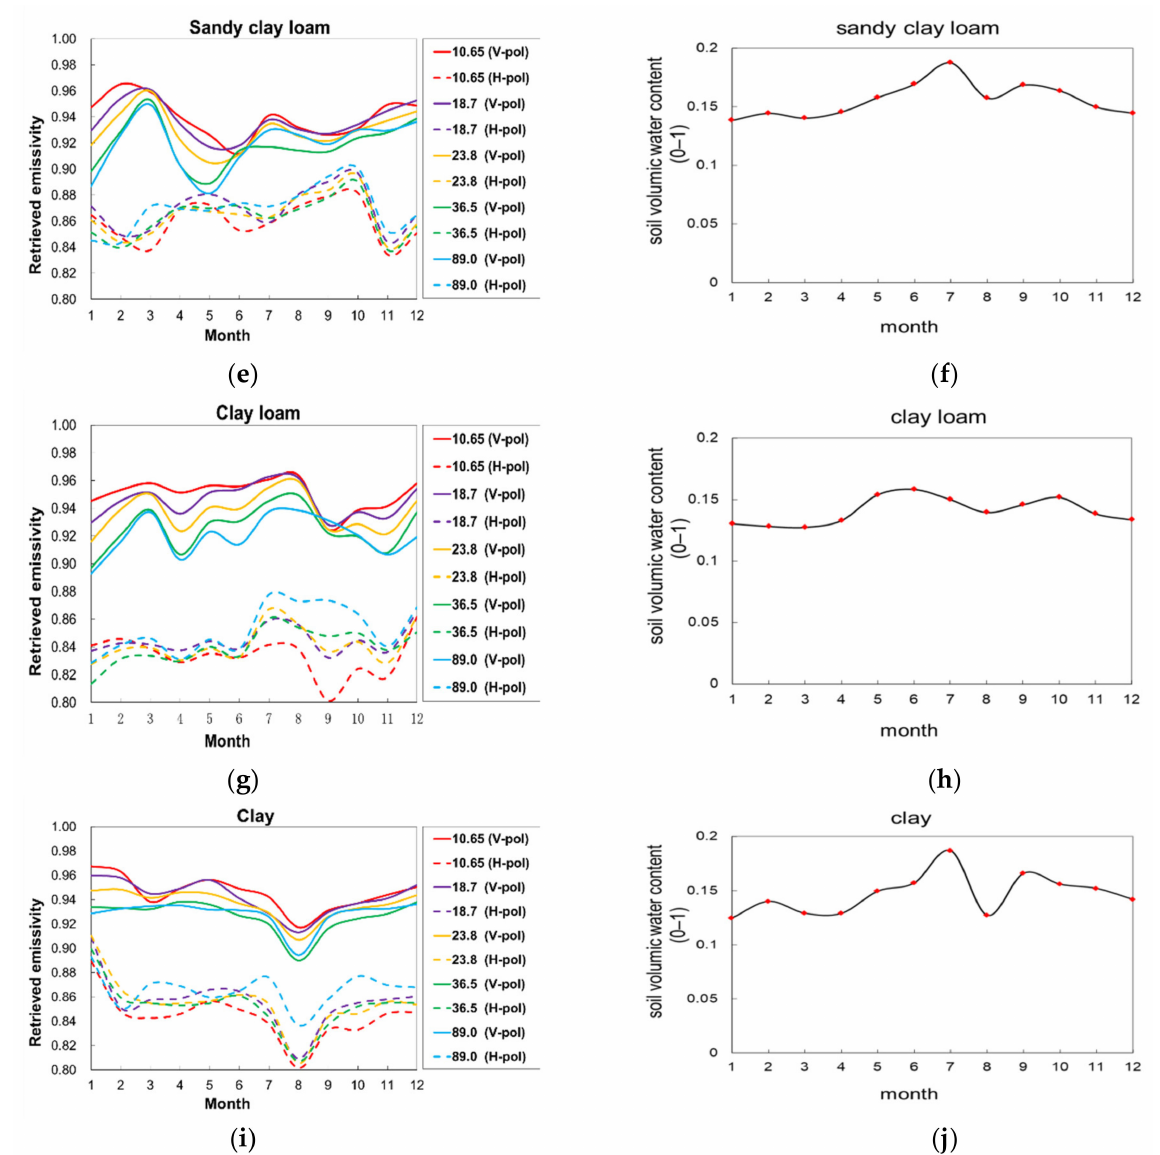
Figure 3. MeanRetrieved emissivity retrievals and mean soil volumic water content for different soil types over the Taklimakan Desert: ( a , b ) sand; ( c , d ) loam; ( e , f ) sandy clay loam; ( g , h ) clay loam; ( i , j )